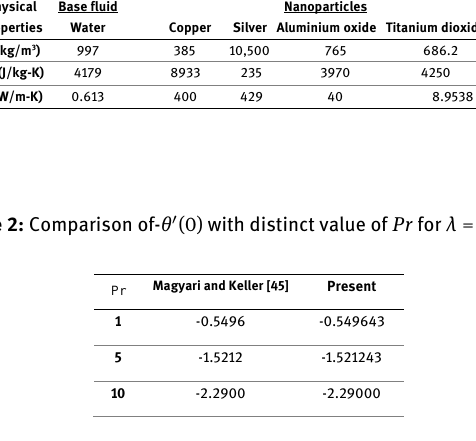
Table 1: Thermo-physical Properties of the base fluids and nanopar- ticles.